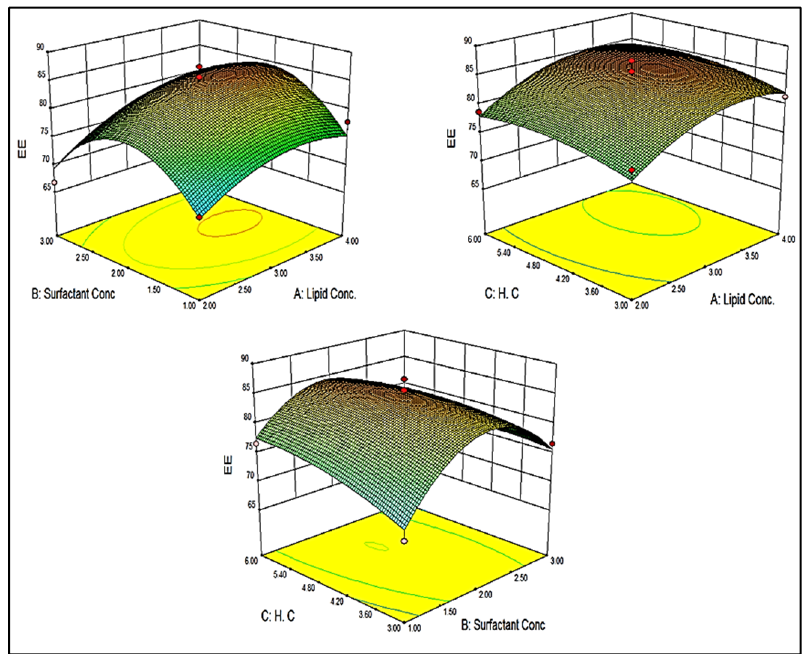
Figure 3. 3D response surface plot showing the effect of independent variables on entrapment efficiency.